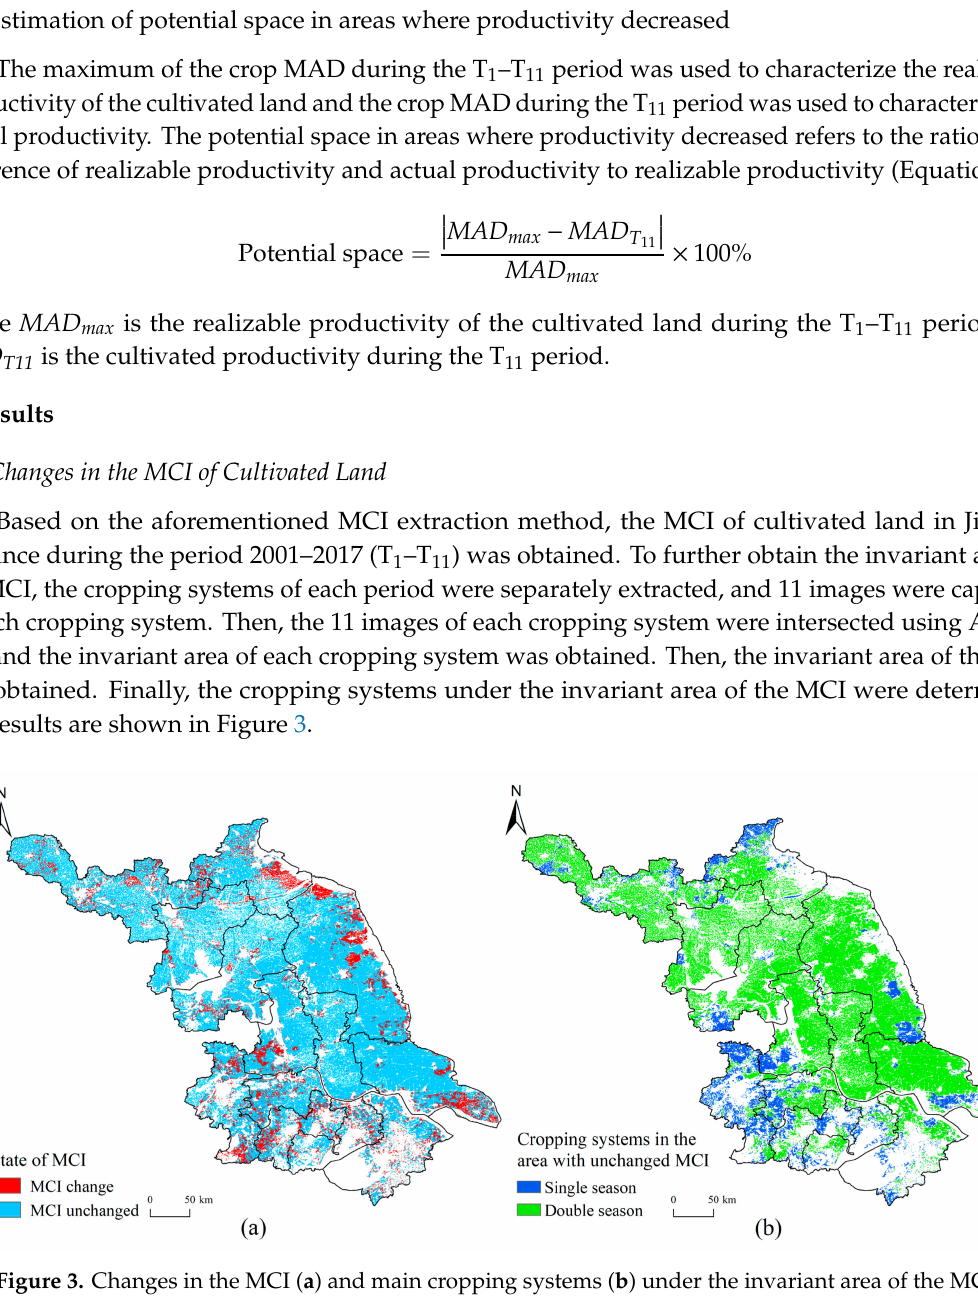
Figure 3. Changes in the MCI ( a ) and main cropping systems ( b ) under the invariant area of the MCI in Jiangsu Province during the period